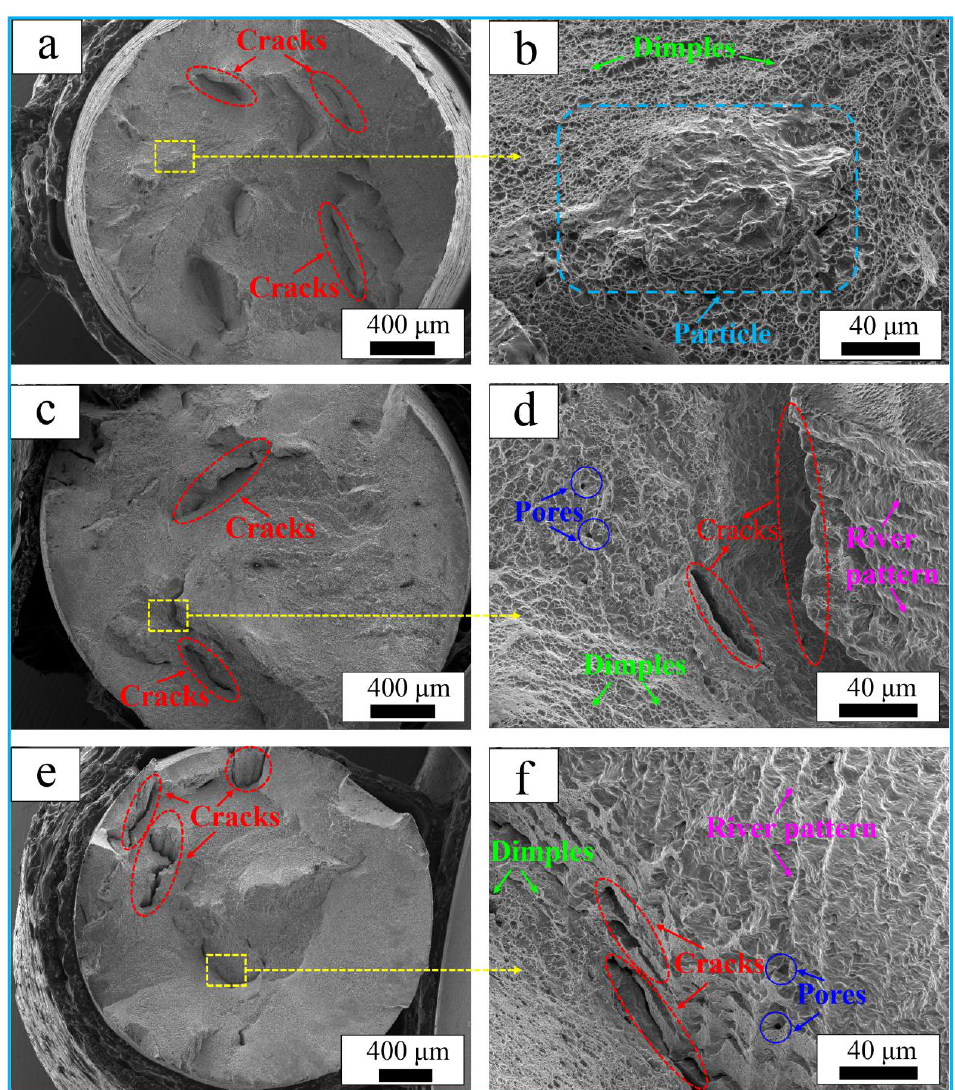
Figure 7. Micrographs of the fracture surfaces of the tensile-tested samples: ( a , b ) APHT-1; ( c , d ) APHT-2; ( e , f ) APHT-3.